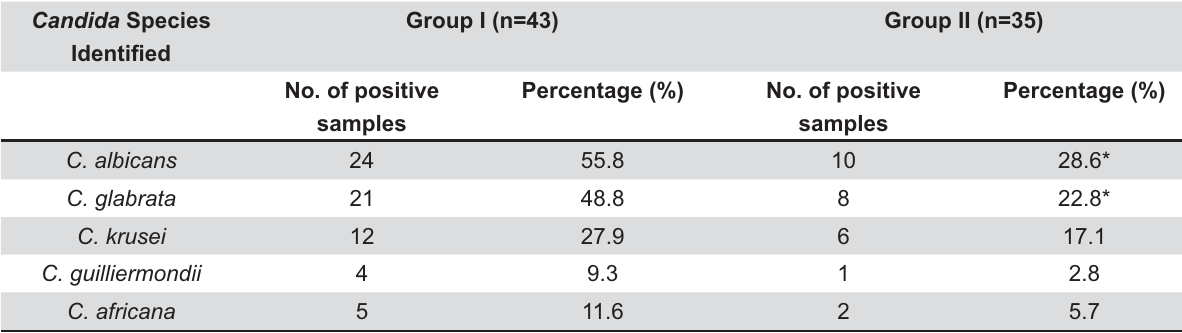
Table 1- (cid:19)((cid:25)(cid:14)(cid:13)(cid:10)(cid:12)(cid:26)(cid:8)(cid:18)(cid:10)(cid:12)(cid:6)(cid:13)(cid:19)(cid:6)(cid:23) Candida species and their percentage of